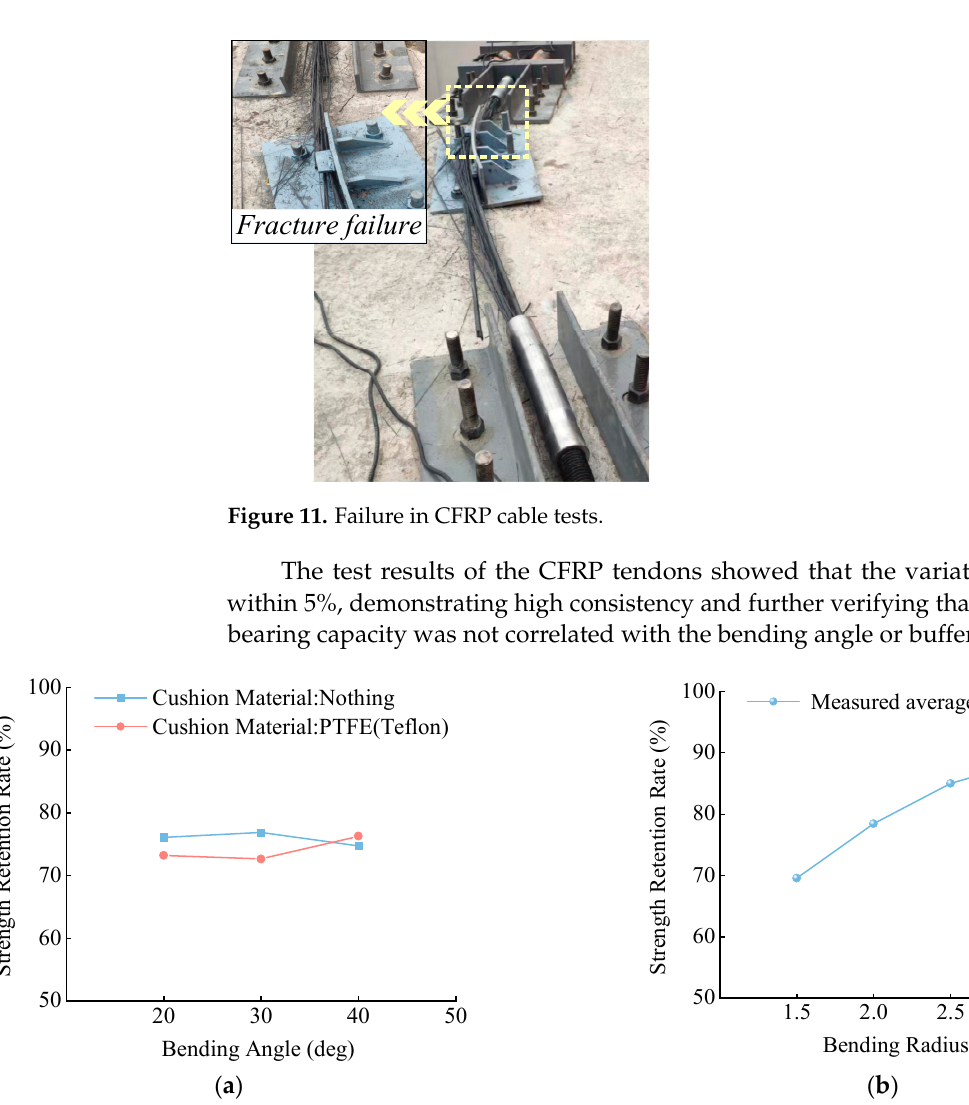
Table 5. Test and theoretical values of bending bearing capacity.